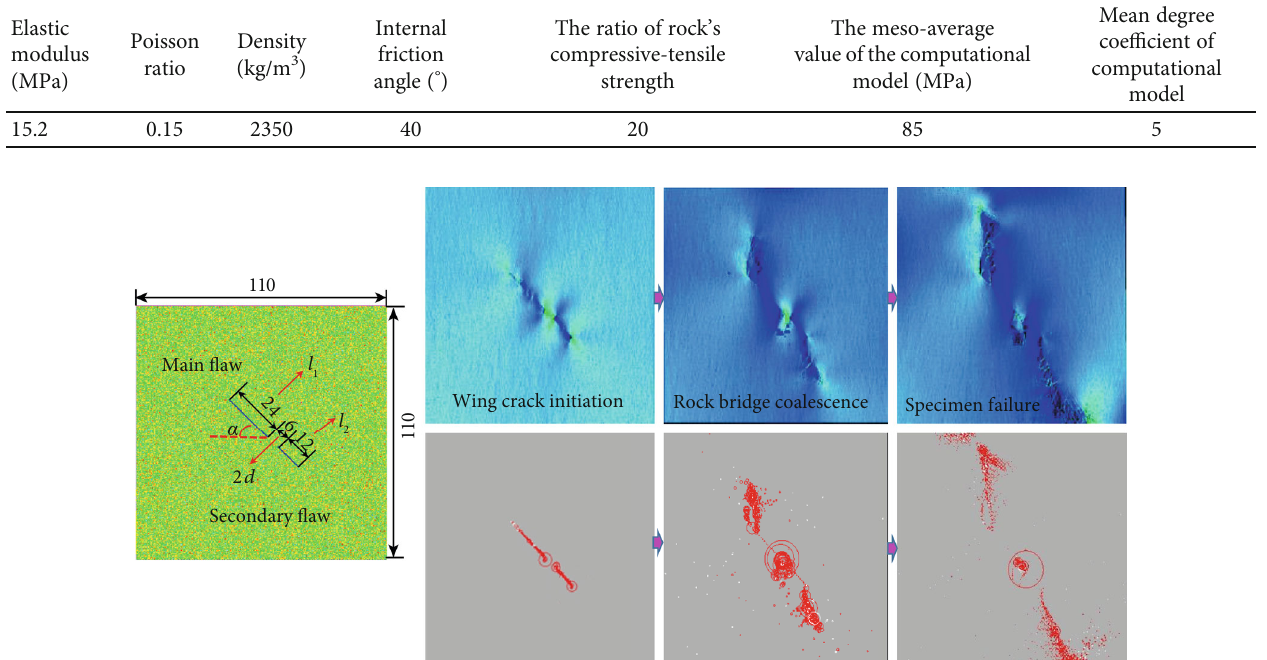
Figure 17: Numerical model and numerical results model 1: α = 45 ° , 2 l